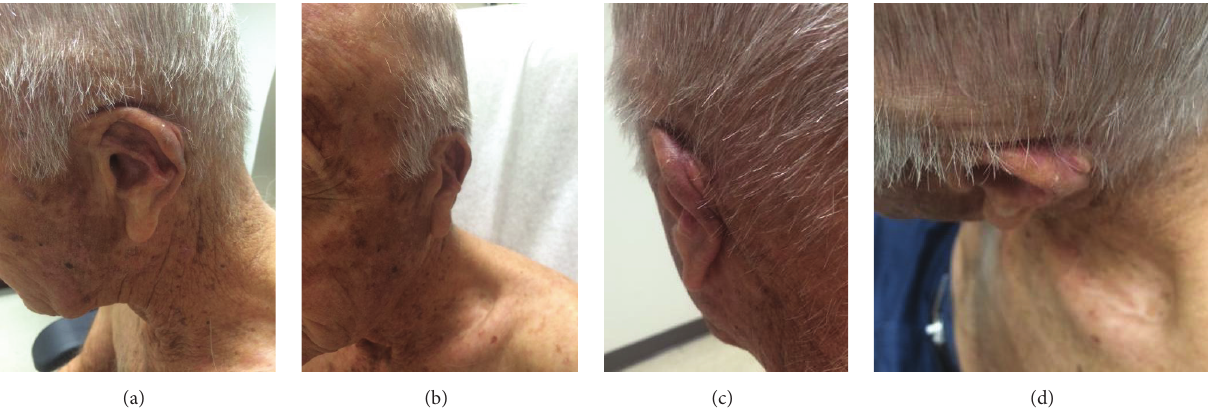
Figure 8: Three-month postoperative